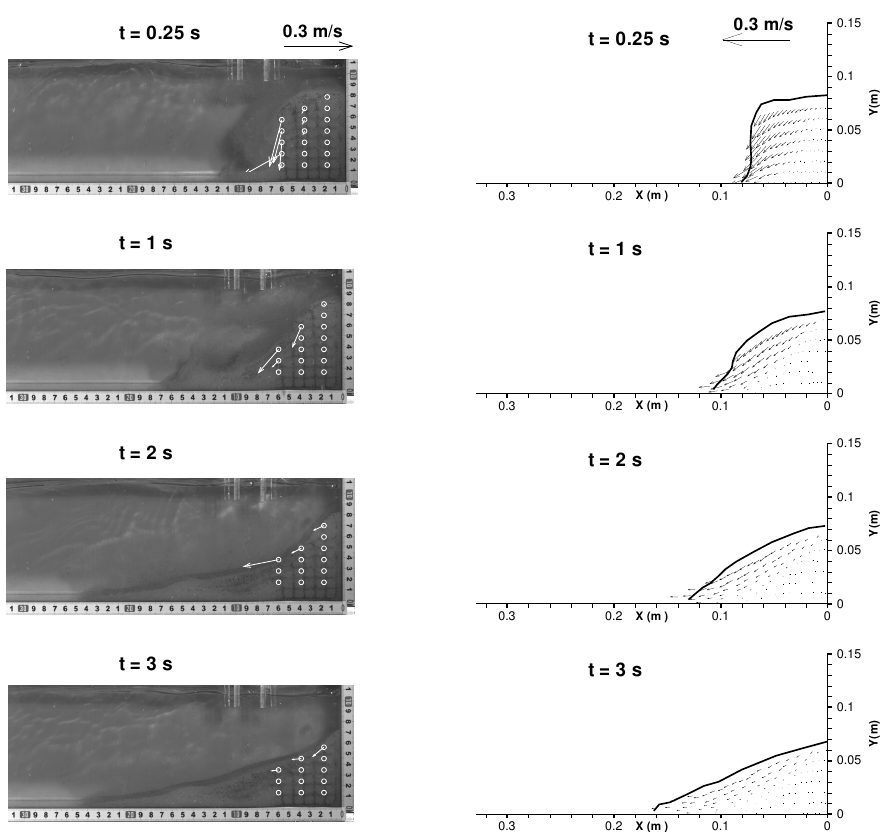
Figure 11. Granular velocity fields at some representative times for the initially dense packing column collapse. Left column: experimental observations; Right column: numerical simulations.